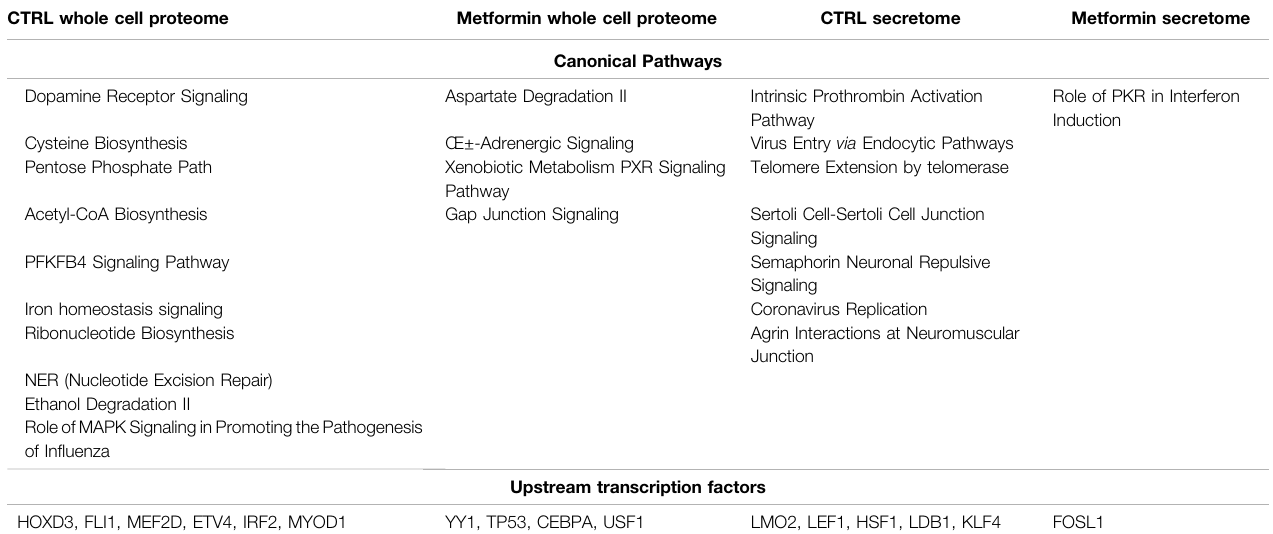
TABLE 2 | IPA analysis followed by Venn